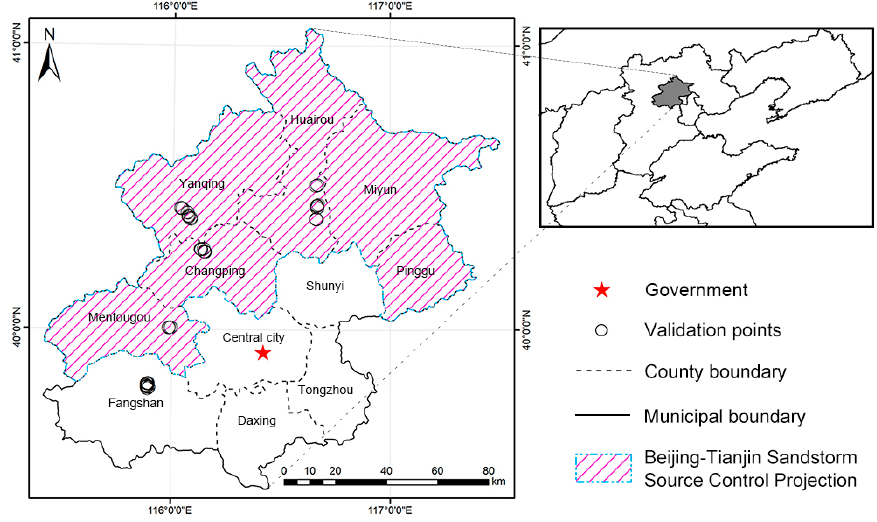
Figure 1. Location of study area and the field observation sites.